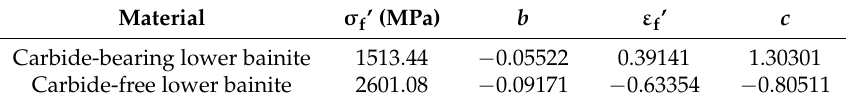
Table 5. Summary of the fatigue strength and fatigue ductility properties.